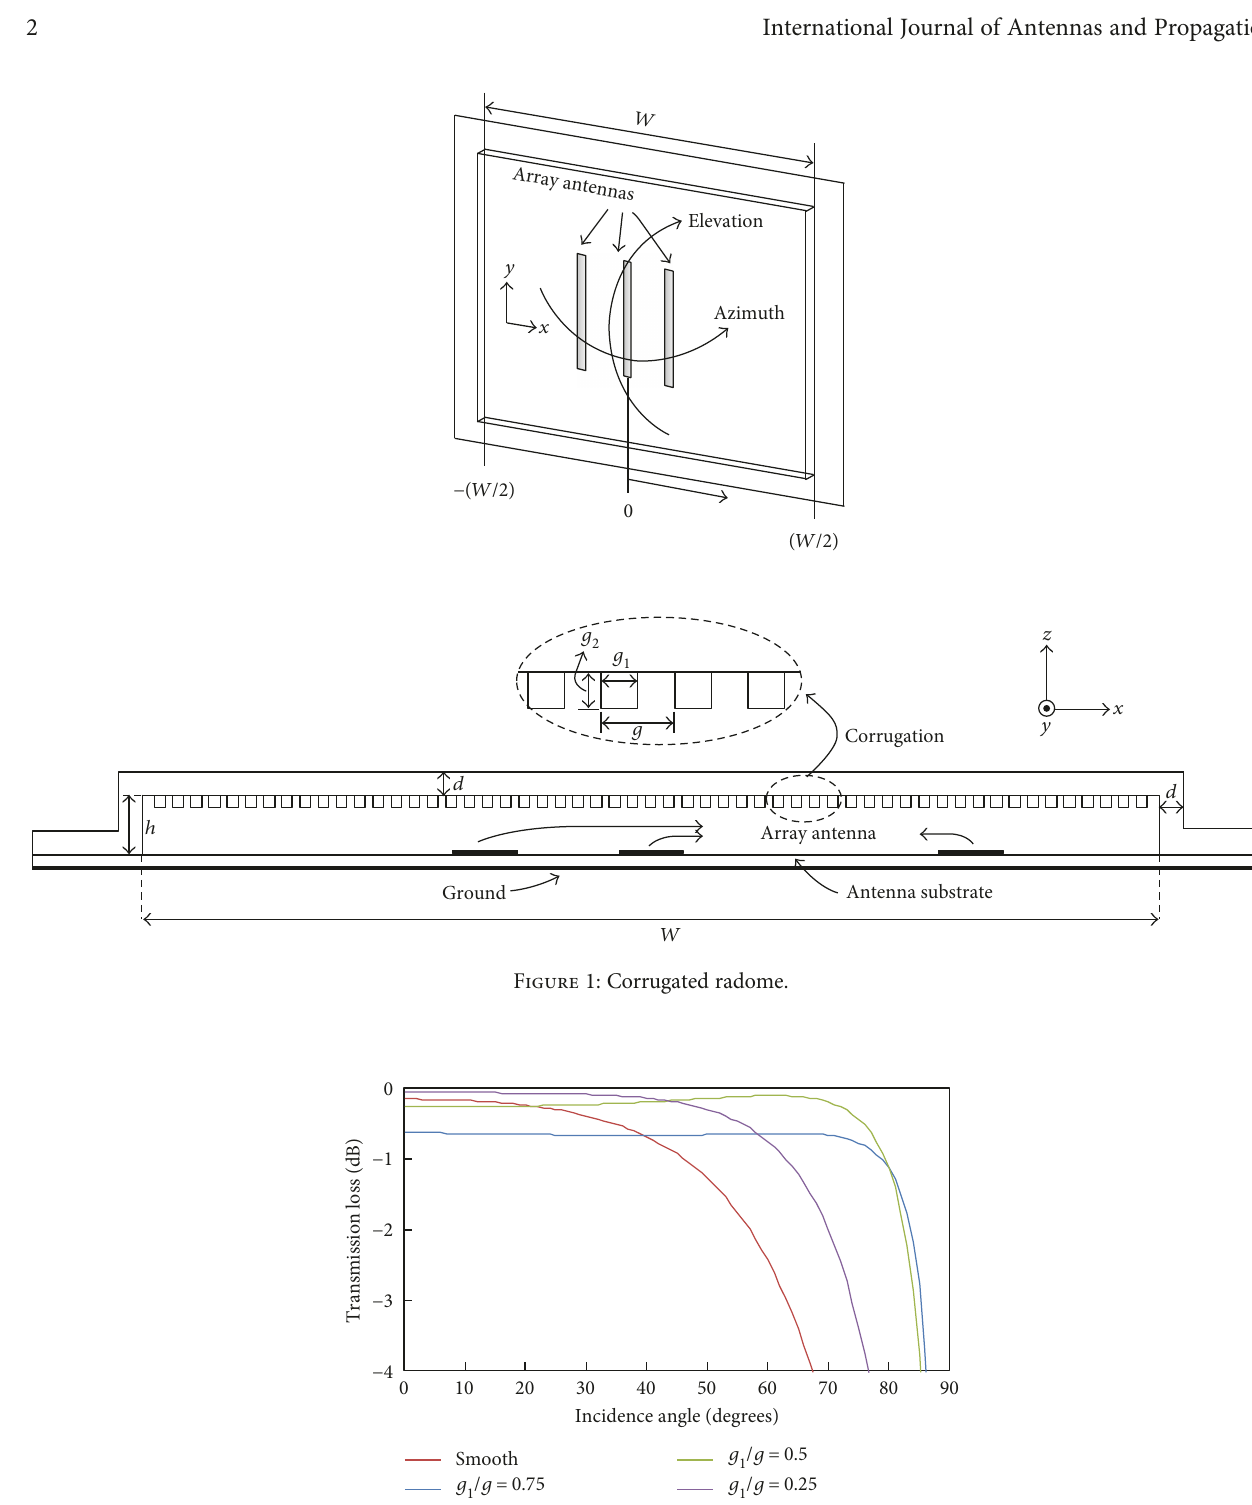
Figure 2: Comparison of transmission loss at 76.5GHz for di ff erent g